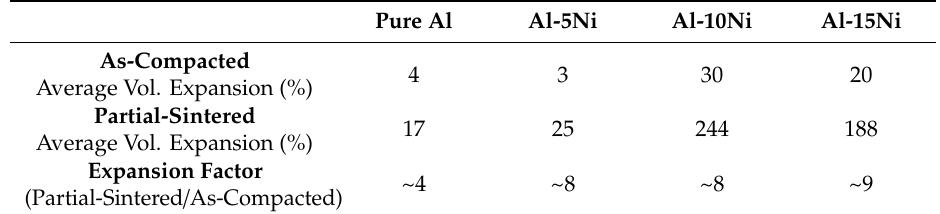
Table1. AveragevolumeexpansionofAlfoamscontaining7wt.%dolomiteresultingfromas-compacted and partially sintered precursors for various Ni